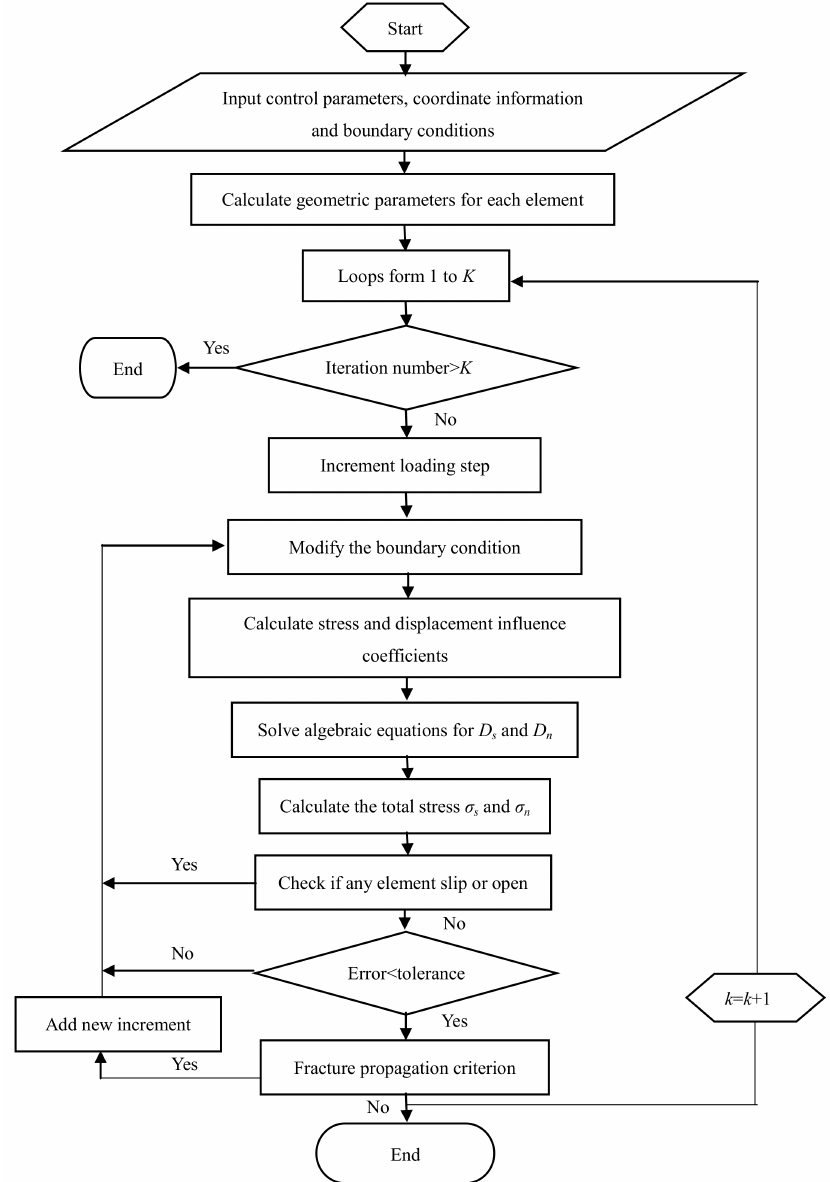
Figure 5. Flowchart of the computing